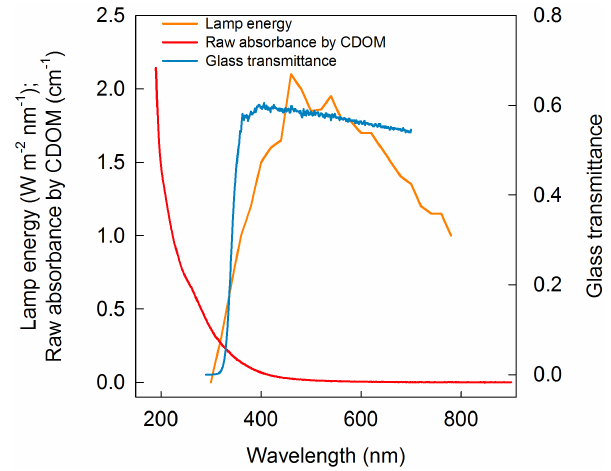
Figure A1. Comparing the lamp spectrum to light absorption from the glass and from CDOM. The same scan was used to correct for absorption of light by glass for all the samples, whereas the cor- responding CDOM scan was used for each sample; the illustrated CDOM scan corresponds to a representative river sample.